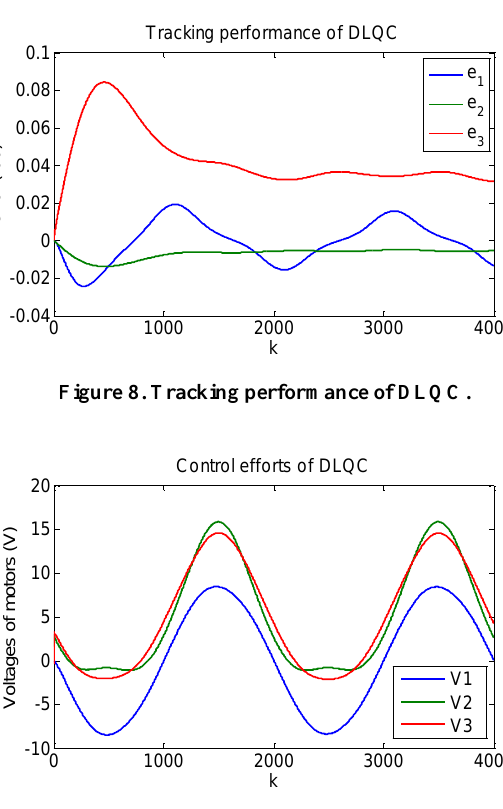
Figure 9. Control efforts of DLQC.